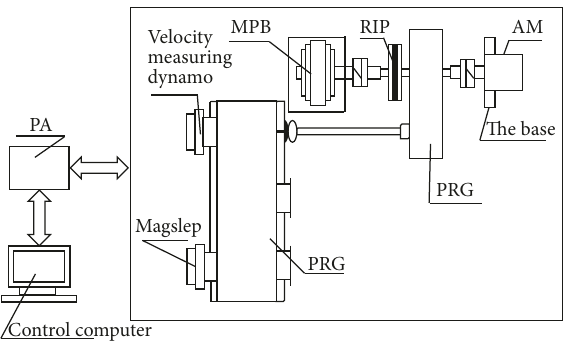
Figure 11: Schematic of the semiphysical simulation platform.